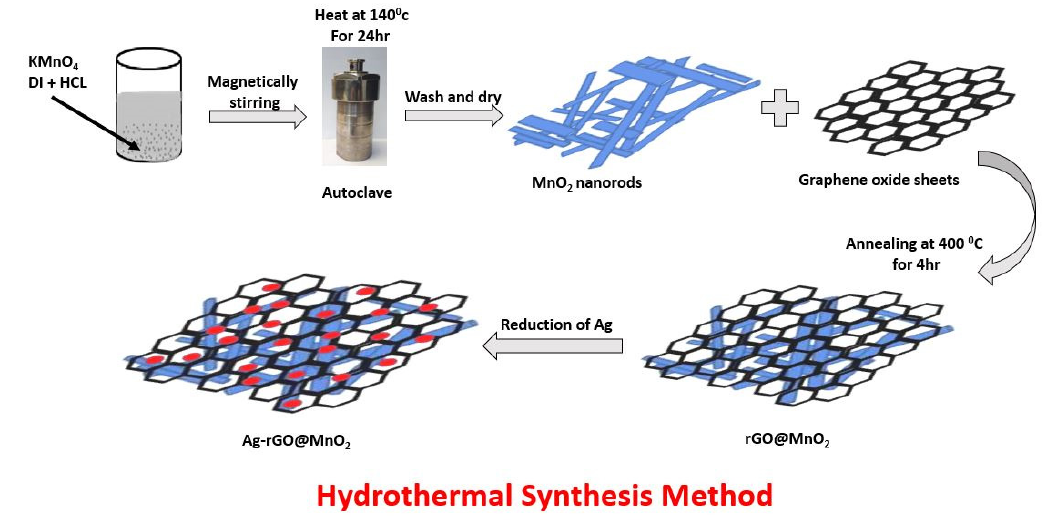
Figure 1. Schematic illustration for the synthesis of Ag-rGO@MnO 2 nanocomposite.